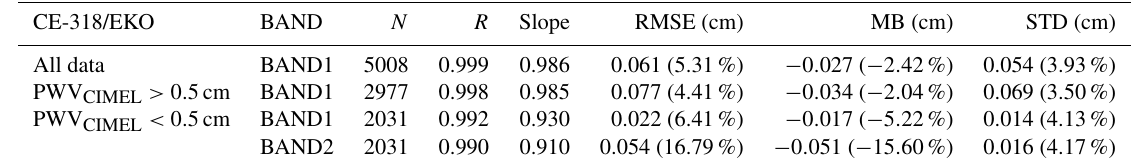
Table 4. Statistics of the comparison between PWV EKO and the PWV CIMEL ( N : number of data, R : Pearson correlation coefficient, Slope: slope of the least squares fit between PWV EKO and PWV CIMEL , RMSE: root mean square error, MB: mean bias, STD: standard deviation).